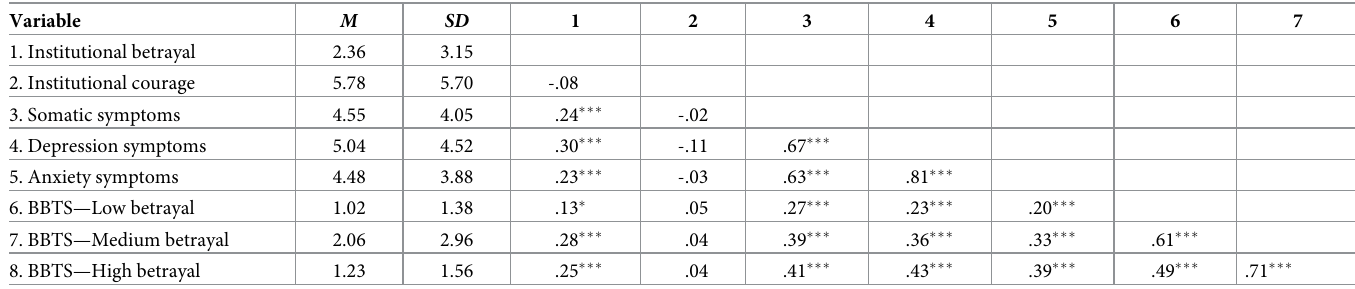
Table 5. Means, standard deviations, and bivariate correlations between IBQ, ICQ-Specific, and employee psychological and physical health outcomes.